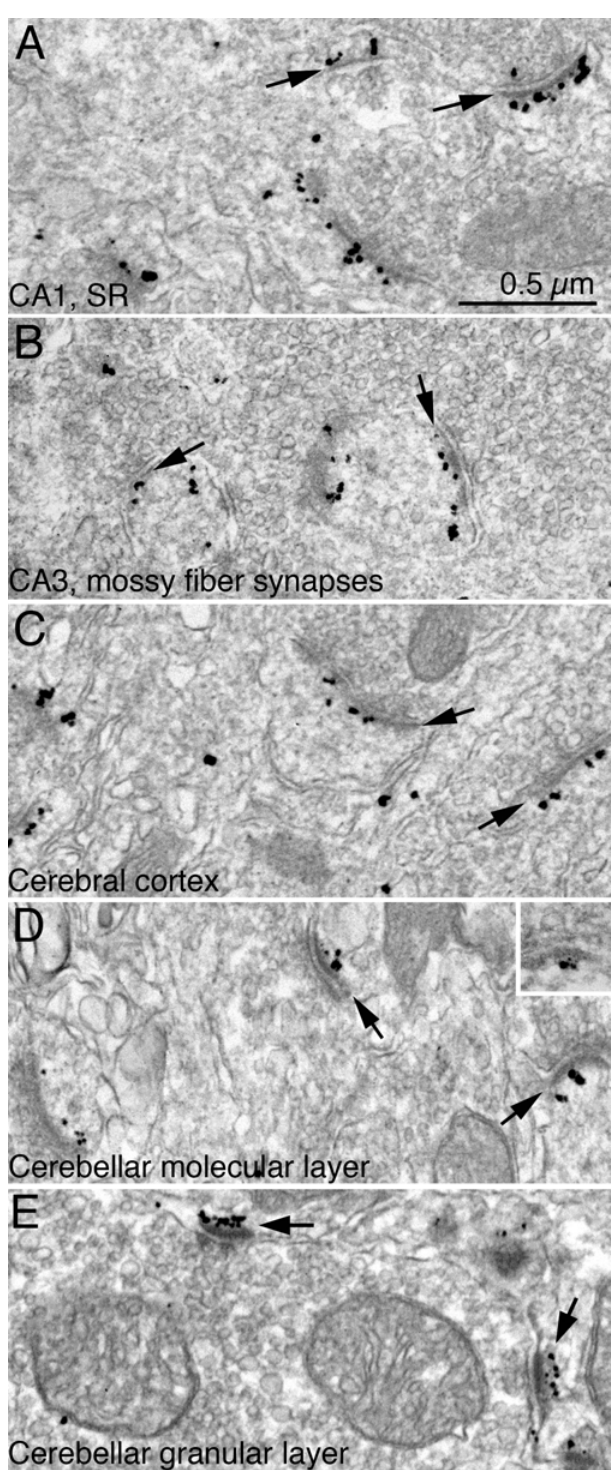
Fig 3. Electron micrographs from perfusion fixed-mouse brain showing immunogold labeling for Shank3 using ab1 (A-E) and ab3 (D, inset). PSDs (arrows) were labeled in all regions examined, including hippocampus [stratum radiatum (SR) of the CA1 region (A), mossy fiber synapses in the CA3 region (B)], cerebral cortex (C), and the outer molecular layer (D) and granular layer (E) of the cerebellum. Scale bar = 0.5 μ